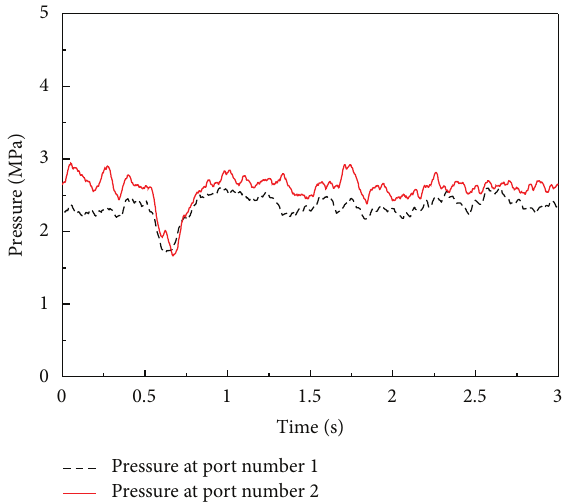
Figure 15: Pressure variations of optimal PID position control system for EHA without load disturbance (only mass load is applied).